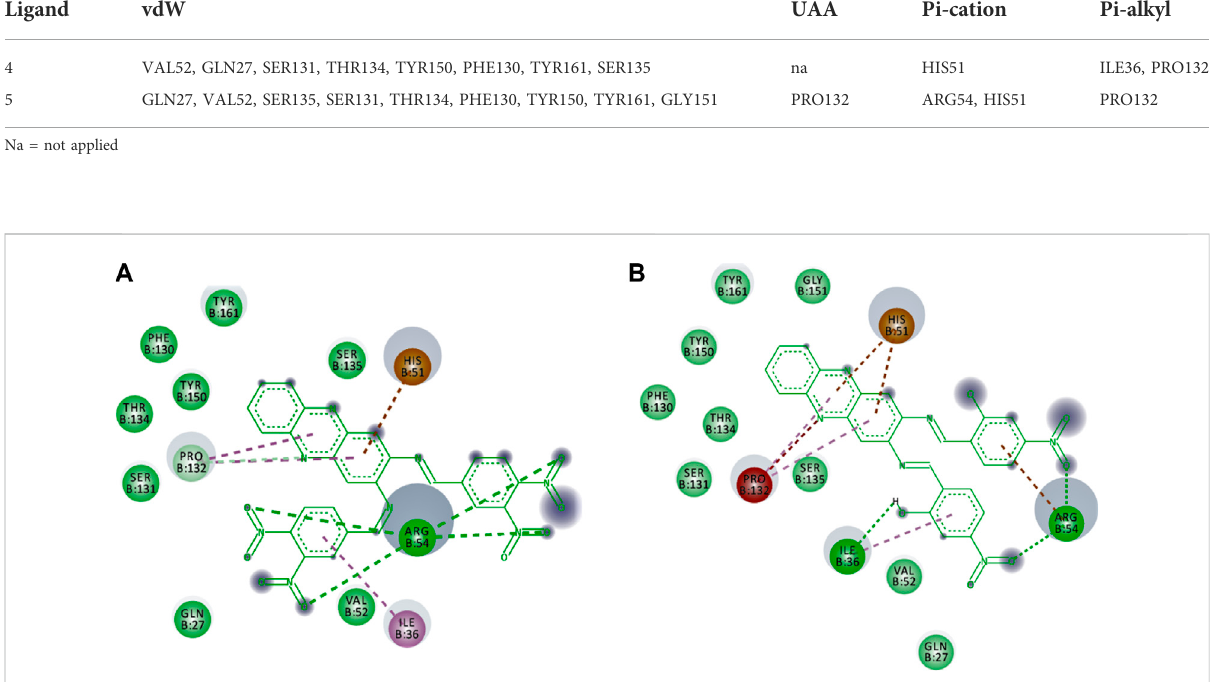
FIGURE 7 The non-bonding type environment of (A) compounds 4 and (B) 5 which might support their docked conformations. The colours of deep green, green, pale green, brown, magenta, pink, and grey represent vdW, H-bond, C-H bond, pi-cation, pi-pi-T shaped, pi-alkyl, and solvent exposures and interactions,